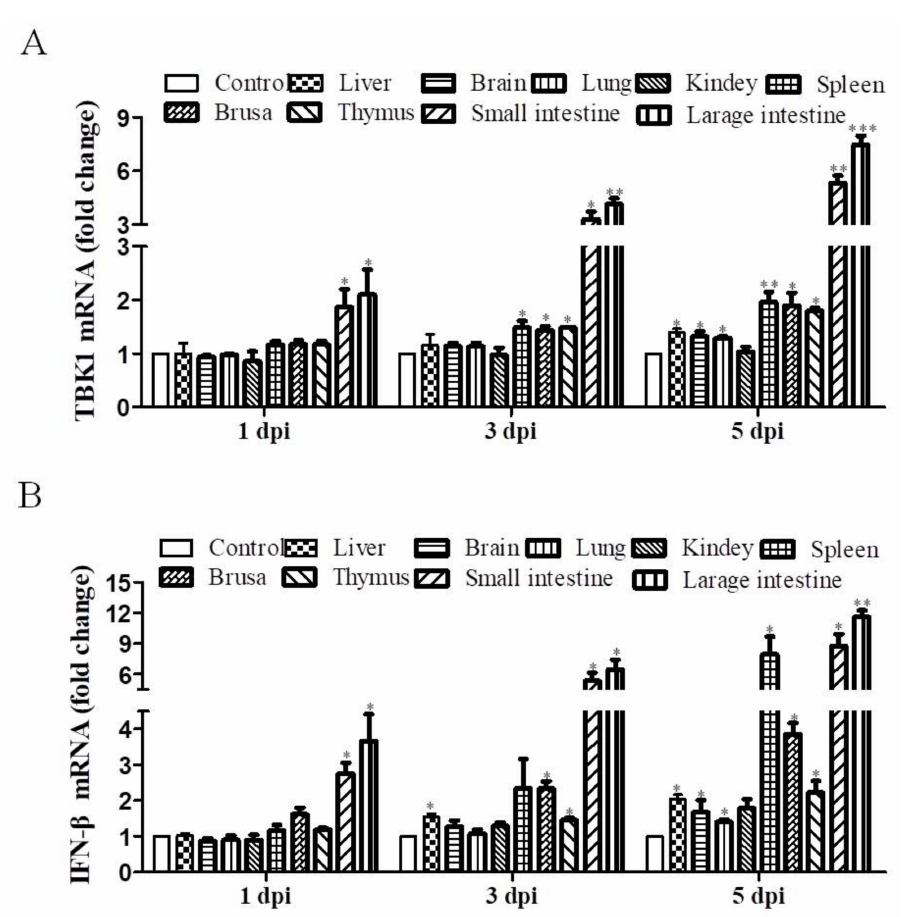
Figure 2. DEV infection induces TBK1 and IFN- β expression in vivo. ( A , B ) Eighteen 21-day-old SPF ducks were divided into an infection group randomly (intramuscular injection of 0.2 mL DEV (2 × 10 4 TCID 50 ) and a control group (intramuscular injection of 0.2 mL EMEM). For qRT-PCR analysis, three ducks from each group were killed and tissue samples were collected at 1, 3, and 5 dpi. ( A ) TBK1 mRNA expression levels in different organs and at the indicated time points. ( B ) IFN- β mRNA expression levels in different organs and at the indicated time points. Mean ± SD of three technical replicates are shown. * p < 0.05, ** p < 0.01, *** p <